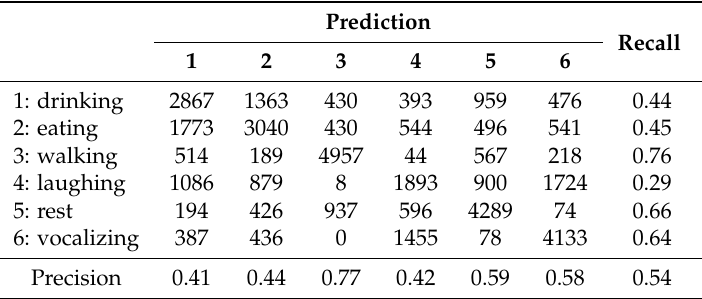
Table 3. Confusion matrix of all subjects.